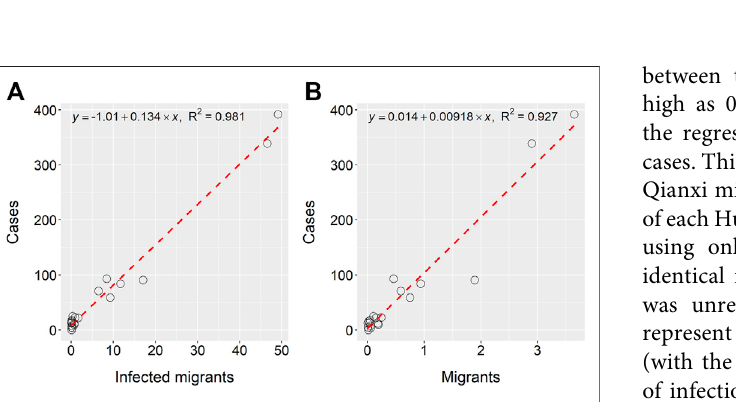
Frontiers in Environmental Science |